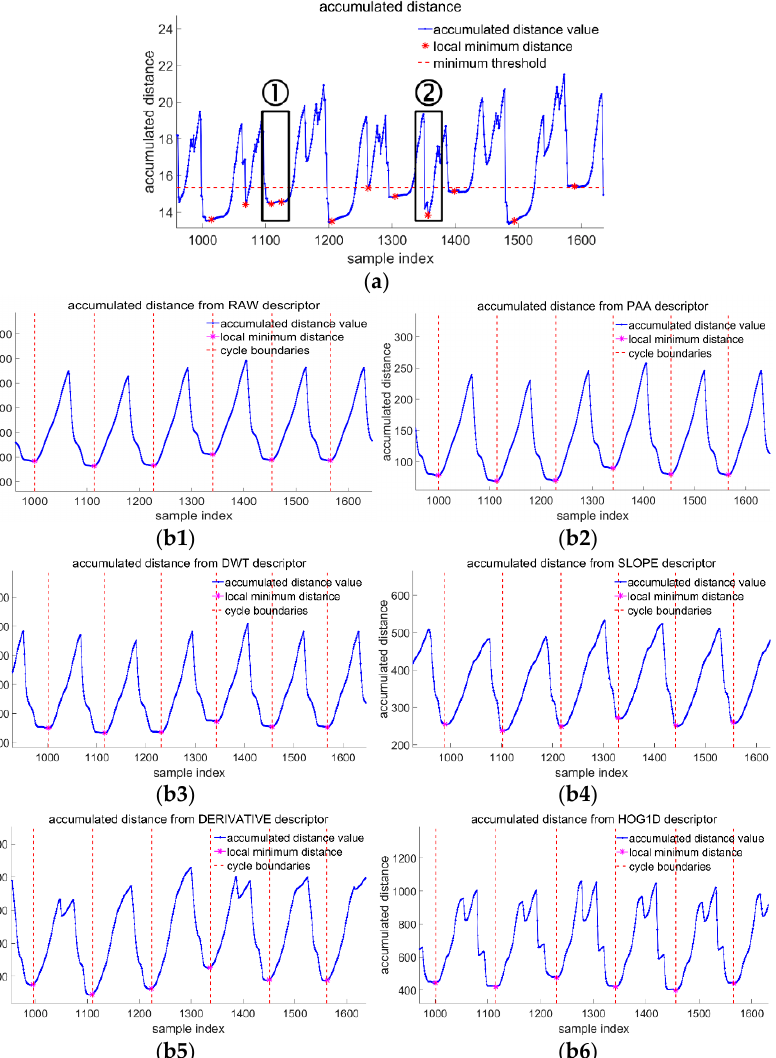
Figure 5. The accumulated distance curve used in conventional DTW methods may contain spikes leading to pseudo-minimums, and multi-valleys blurring the stride boundaries. Shape descriptors are able to improve the smoothness and monotonicity of the accumulated distance curve. ( a ) accumulated distance in conventional DTW; ( b1 ) accumulated distance from RAW descriptor; ( b2 ) accumulated distance from PAA descriptor; ( b3 ) accumulated distance from DWT descriptor; ( b4 ) accumulated distance from SLOPE descriptor; ( b5 ) accumulated distance from DERIVATIVE descriptor; ( b6 ) accu- mulated distance from HOG1D